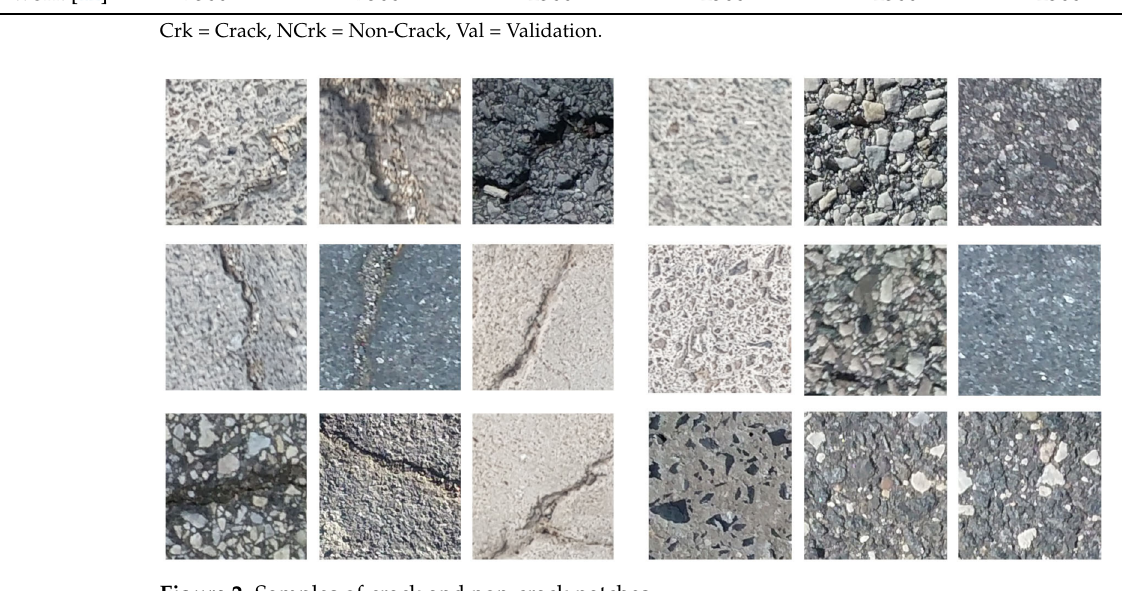
Figure 2. Samples of crack and non-crack